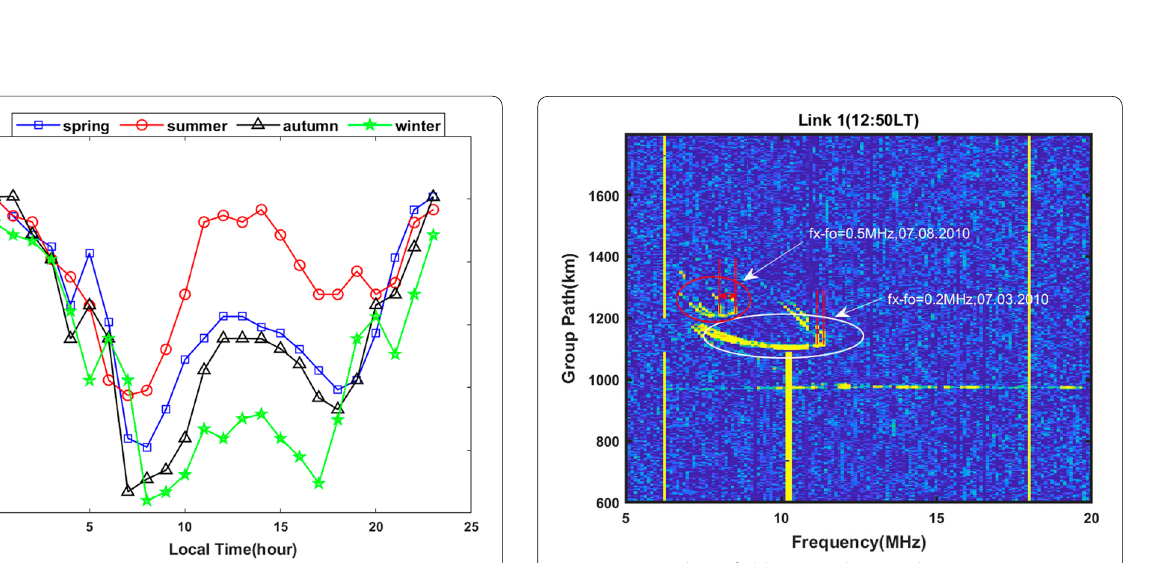
Fig. 10 Seasonal variation of the peak height of the F2-layer observed in Xi’an; blue, red, black, and green lines represent spring, summer, autumn, and winter, respectively